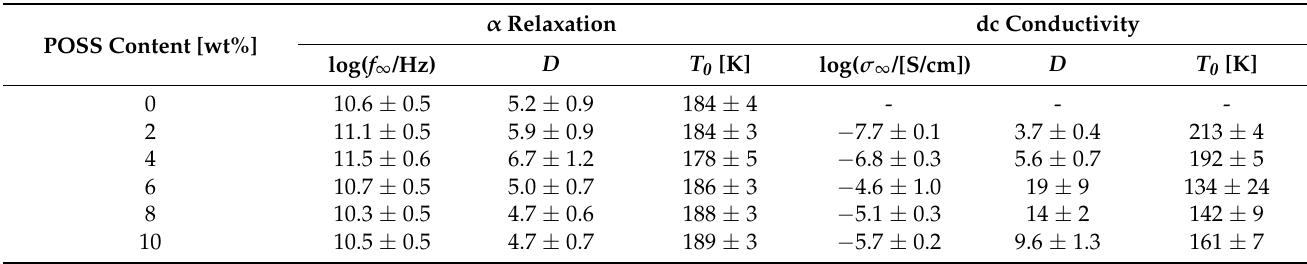
Table 1. Vogel Fulcher Tammann parameters for the α relaxation and conductivity of the blends. Conductivity parameters have been determined for temperatures below peak I.